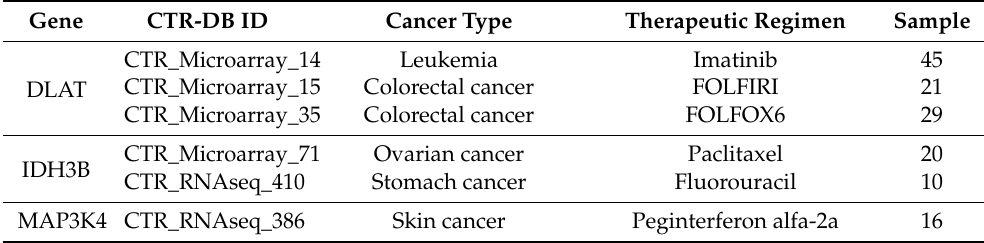
Table 2. Data of drug response from